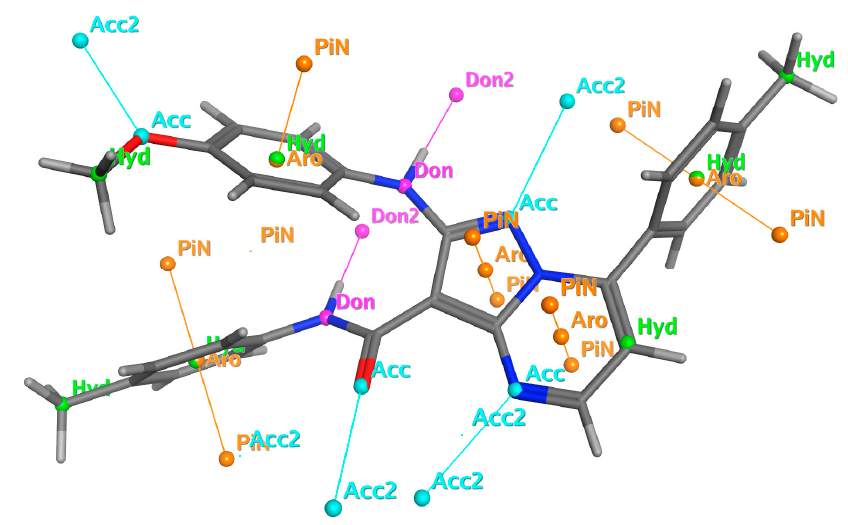
Figure 7. 3D pharmacophore structure of 13e simulated to an active site in alkaline phosphatase (ALP).